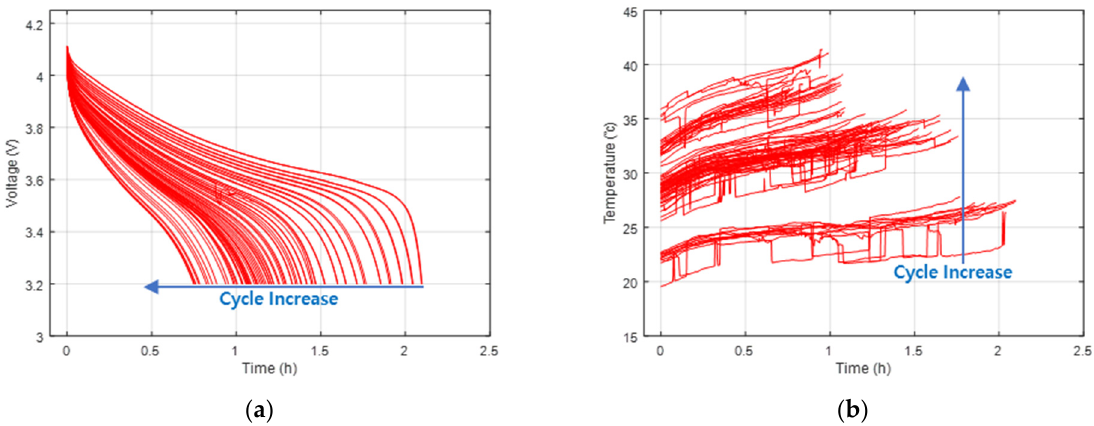
Figure 3. The reference discharge profile of RW9: ( a ) voltage; ( b ) temperature.